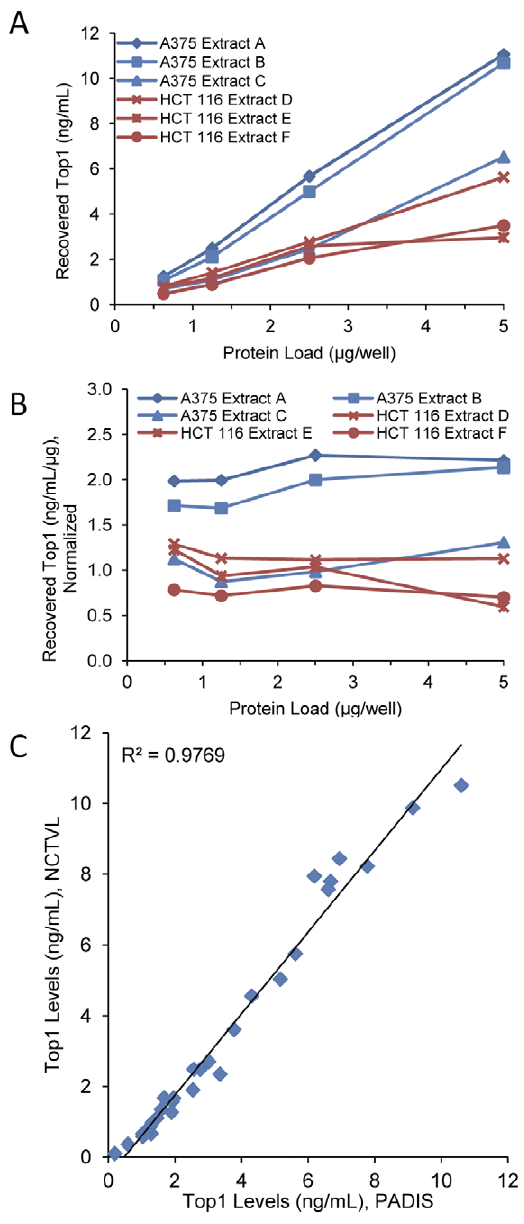
Figure 1. Validation of assay performance. (A) Top1 levels were measured in serial dilutions of three A375 and three HCT 116 xenograft extract samples using the Top1 immunoassay. (B) Total Top1 levels from the diluted extracts in panel A normalized to 1 m g/mL. (C) Comparison of Top1 levels in 24 matched samples and 6 control extracts, measured by two independent laboratories, the Pharmacodynamic Assay De- velopment and Implementation Section (PADIS) laboratory and the National Clinical Target Validation Laboratory (NCTVL). Sample dilution and analysis were performed independently by both laboratories and Top1 levels were compared across